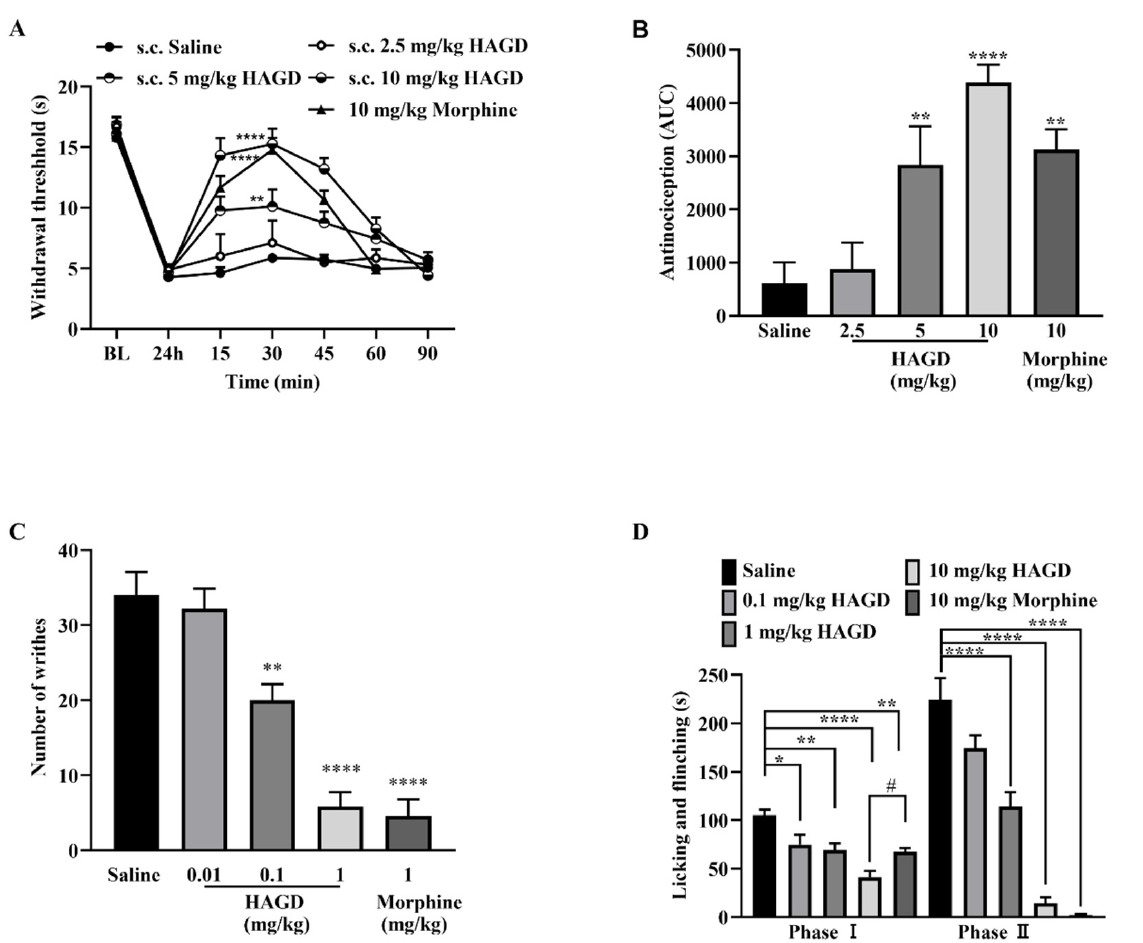
Figure 3. Antinociceptive effects of subcutaneous (s.c.) HAGD. ( A ) Antinociceptive dose- and time- response curve for HAGD and morphine in the carrageenan-induced inflammatory pain, n = 9, 8, 9, 8, 9 mice; ** p < 0.01 and **** p < 0.0001 indicate significant differences compared with the saline group, according to two-way analysis of variance (ANOVA), followed by Bonferroni’s post hoc test; ( B ) The area under the curve (AUC) values of the percentage of the maximal possible effect (MPE%) of HAGD and morphine; ** p < 0.01 and **** p < 0.0001 indicate significant differences compared with the saline group, according to one-way ANOVA, followed by Dunnett’s post hoc test. ( C ) Dose-dependent histogram of HAGD and morphine in the acetic acid-induced writhing test, n = 5, 6, 6, 5, 5